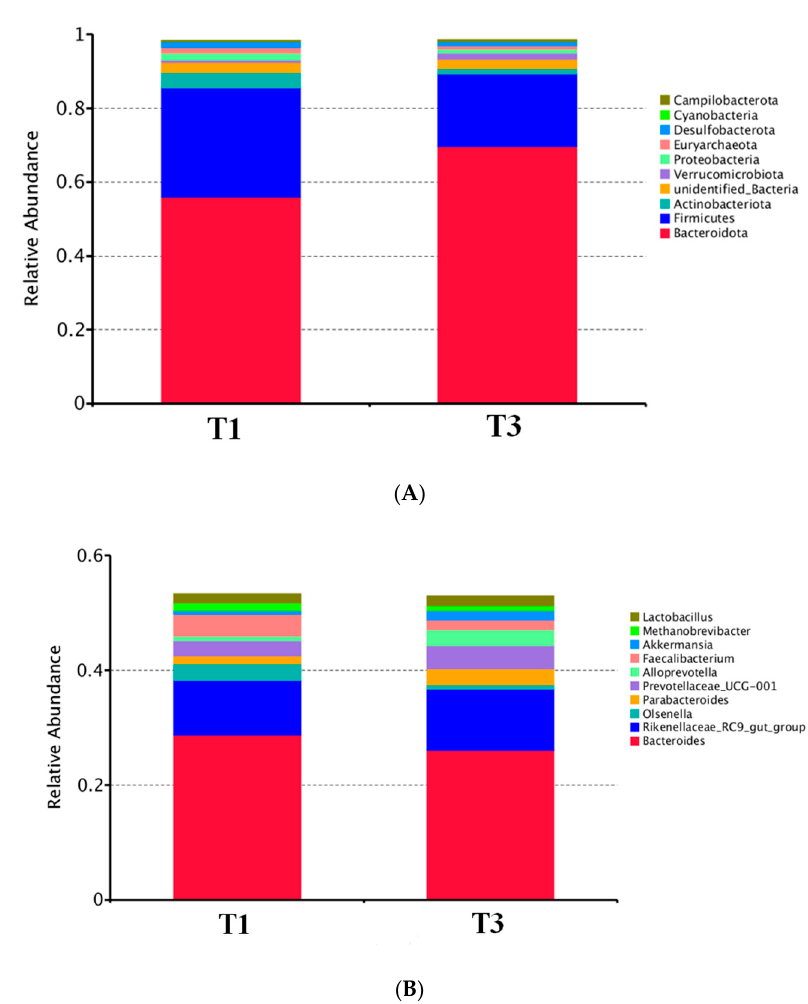
Figure 1. Microbial composition of cecum contents of broilers at phylum ( A ) and genus ( B ) levels. T1: the broilers were fed a basal diet; T3: the broilers were fed a basal diet supplemented with AGE at 0.4%.